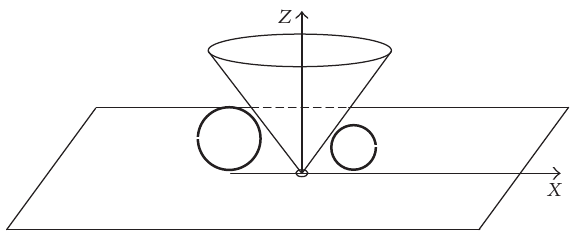
Figure 10: Geometry of a conical monopole UWB antenna with two split loops.